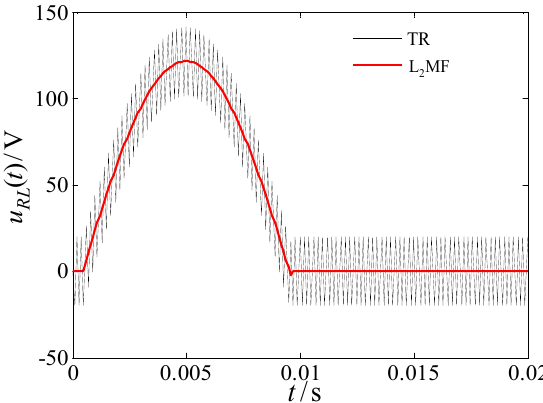
Figure 5. Load voltage calculated by the three-step low-order linear multistep formulae (L 2 MF) method and the implicit trapezoidal integration method(TR).